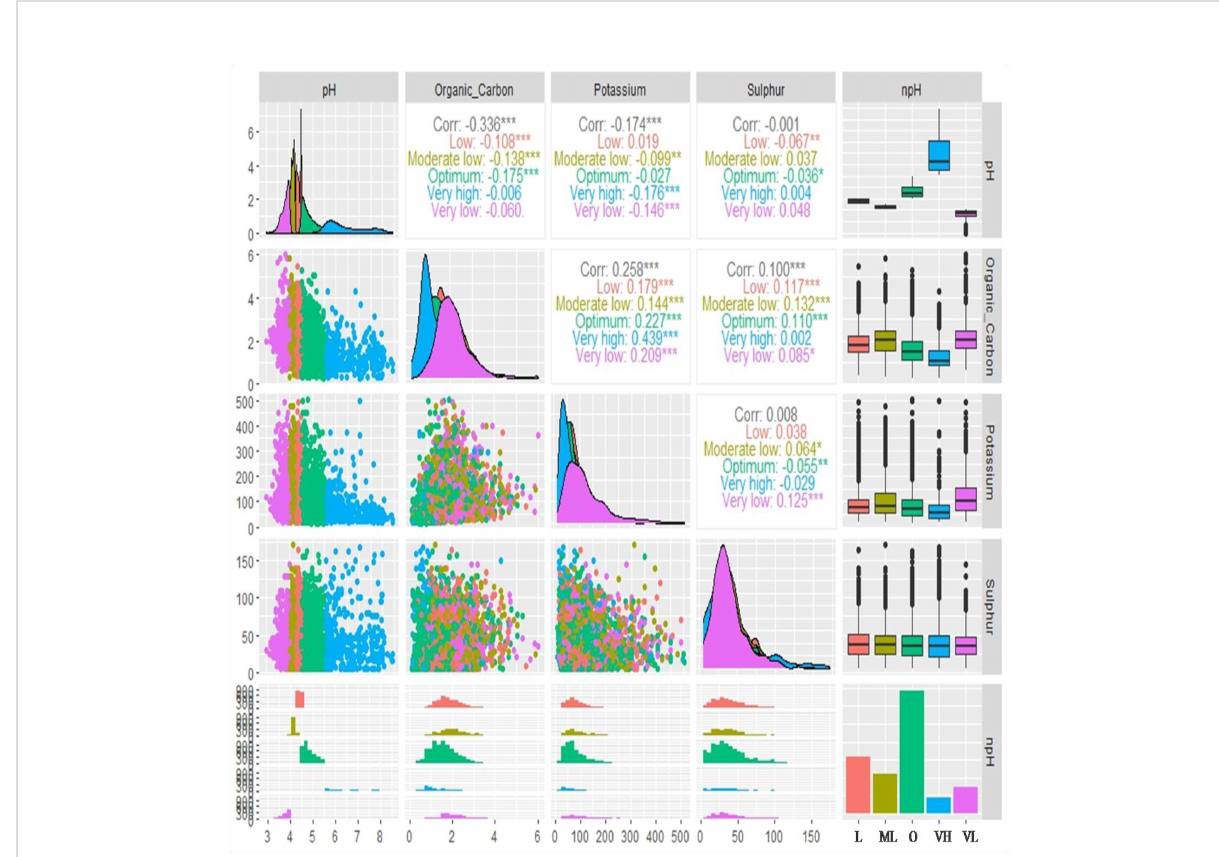
FIGURE 4 Bivariate correlations of reported soil parameters (pH, organic carbon, available potassium, and available sulphur) of 7300 analyzed soil samples against different categories of soil pH represented by box plot, density, scatter, histogram, and bar diagram (in bar diagram L, Low; M, Moderately Low; O, Optimum; VH, Very high and VL, Very low; here ‘ Organic_Carbon ’ is ‘ OC ’ , Potassium is ‘ available potassium (K) as K 2 O ’ abbreviated as ‘ AK ’ in the manuscript and Sulphur is ‘ available sulphur ’ abbreviated as ‘ AS ’ in the manuscript; Signi fi cance codes: “ *** ” at 0.001%, “ ** ” at 0.01% and “ * ” at 0.05%